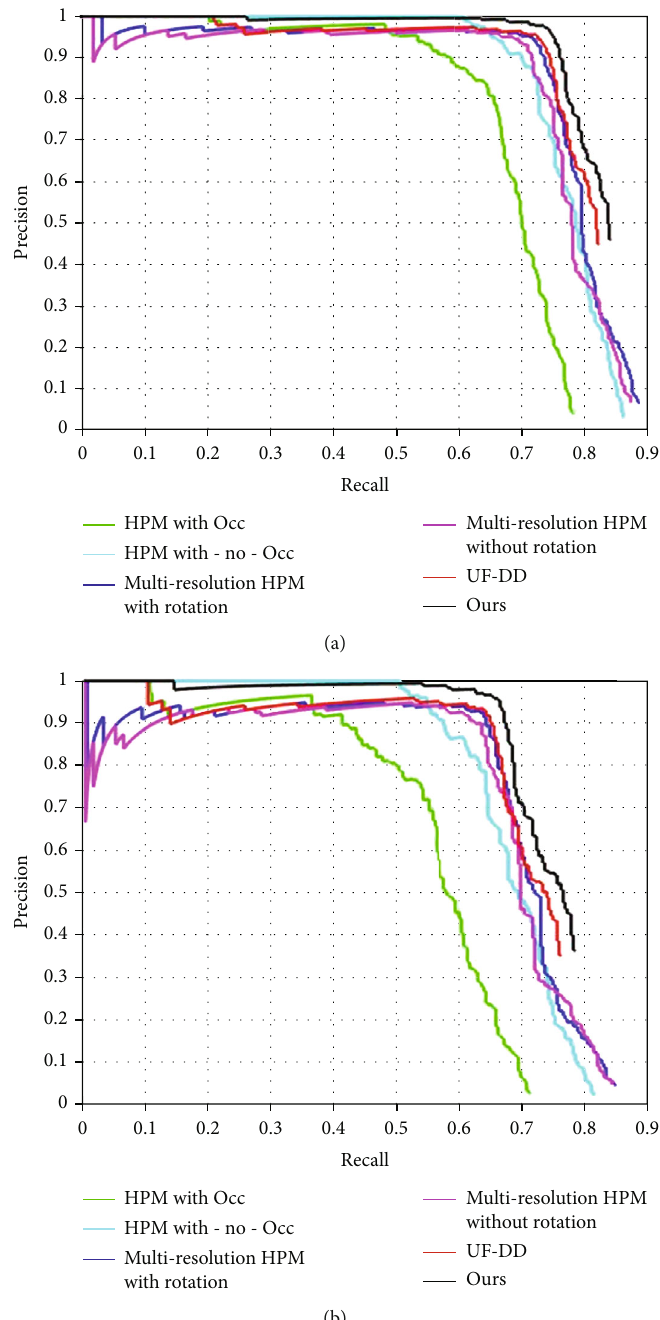
Figure 1: Precision-recall curves of the proposed method and baselines methods on the (a) COFW dataset and (b) LFPW